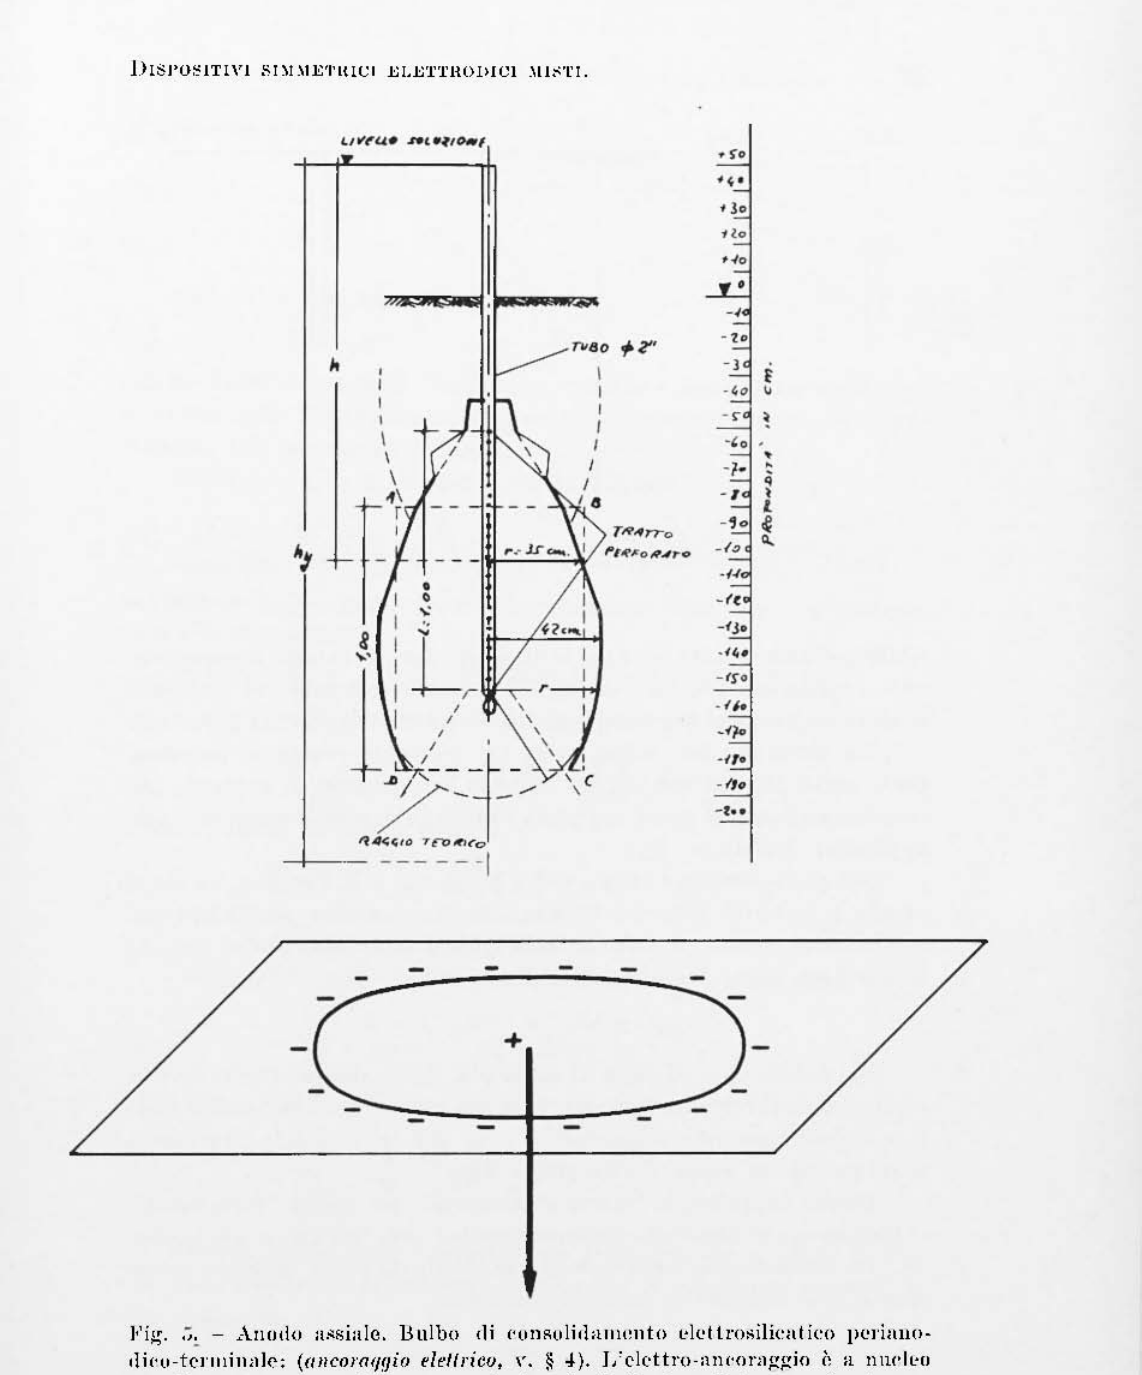
Fig-. ", - AllOdo a.~siale. Bulbo di ('OllRoli,jallwnto l'!ettrosilieatieo periauo * ,ji('o-ì('l'lIlinak-; (ancom/flJio del/rico, l', .,I.). j,'e!ettro-an«()raggio i~ a lllH'll'() allungato, consegllito eon anodo terminale bucherellato ()